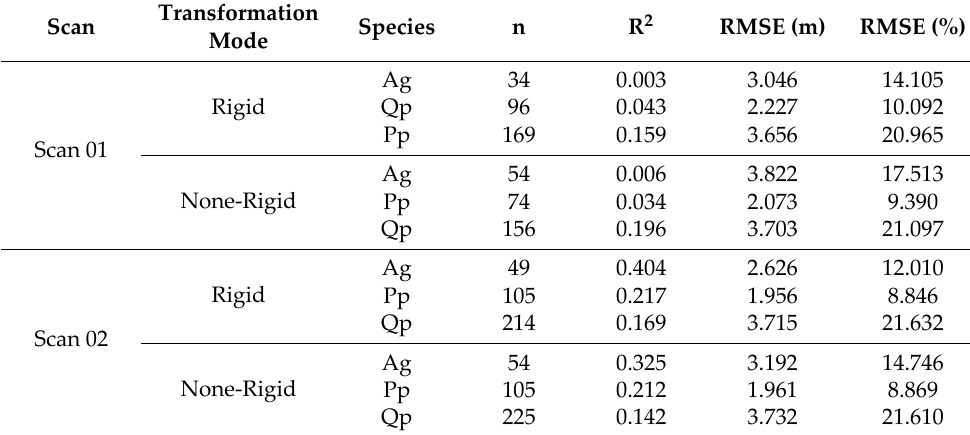
Table 6. Summary statistics for the estimation of tree height using matching tree pairs using linear regression. Detected tee heights were used to estimate field measurements. Fitting statistics and number of observations (n) are presented for each species, scan transformation mode and for the tested scanning paths (Scan 01 and Scan